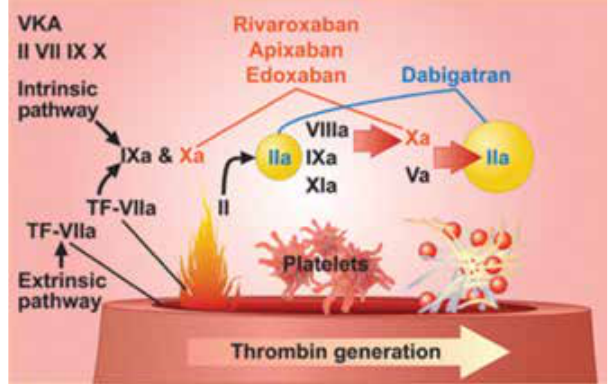
Figure 2. Coagulation process and targets of direct oral anticoagulants (DOACs). Contrary to DOACs, vitamin-K antagonists (VKA) have multiple targets (including factors II, VII, IX and X).